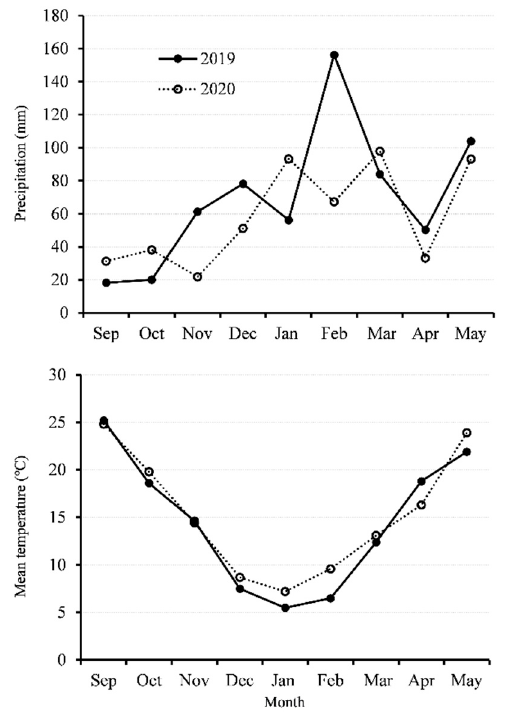
Figure 1. Precipitation and mean temperature during rapeseed growth season in 2018–2019 and